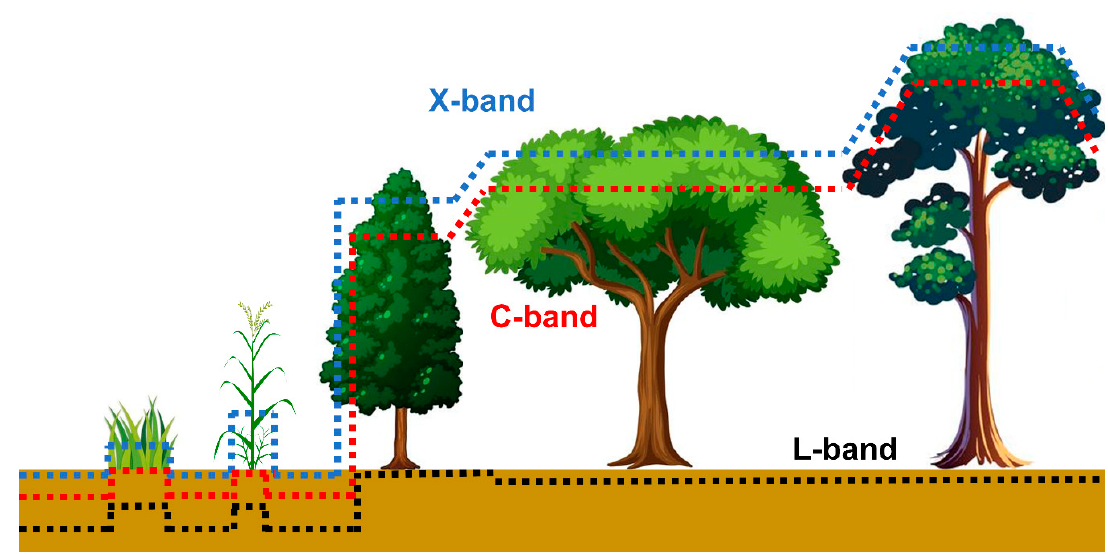
Figure 2. Penetration of the electromagnetic wave in the soil and the vegetation (grass, crop, trees) as a function of the frequency band (X in blue, C in red, and L in black).